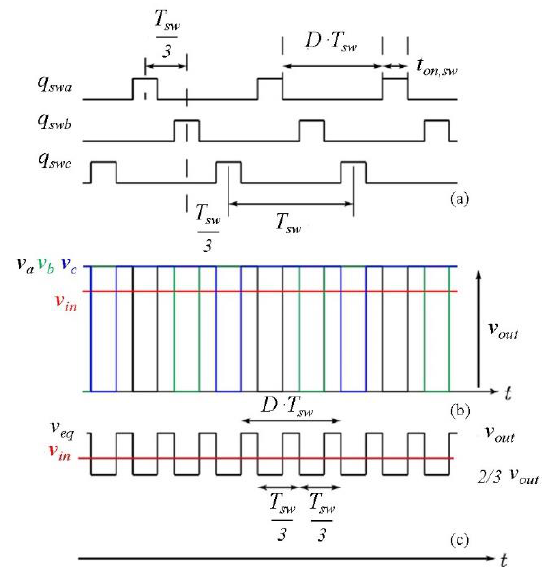
Figure 5. The qualitative switching waveforms in the case of D > 2 / 3. ( a ) The gate signal control, ( b ) the devices switching voltage, ( c ) the equivalent voltage variation.